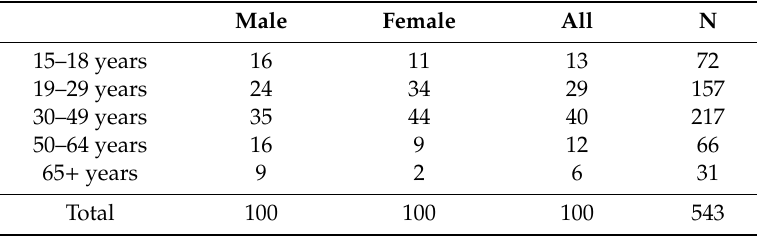
Table 1. Afghan refugee respondents’ demographic background